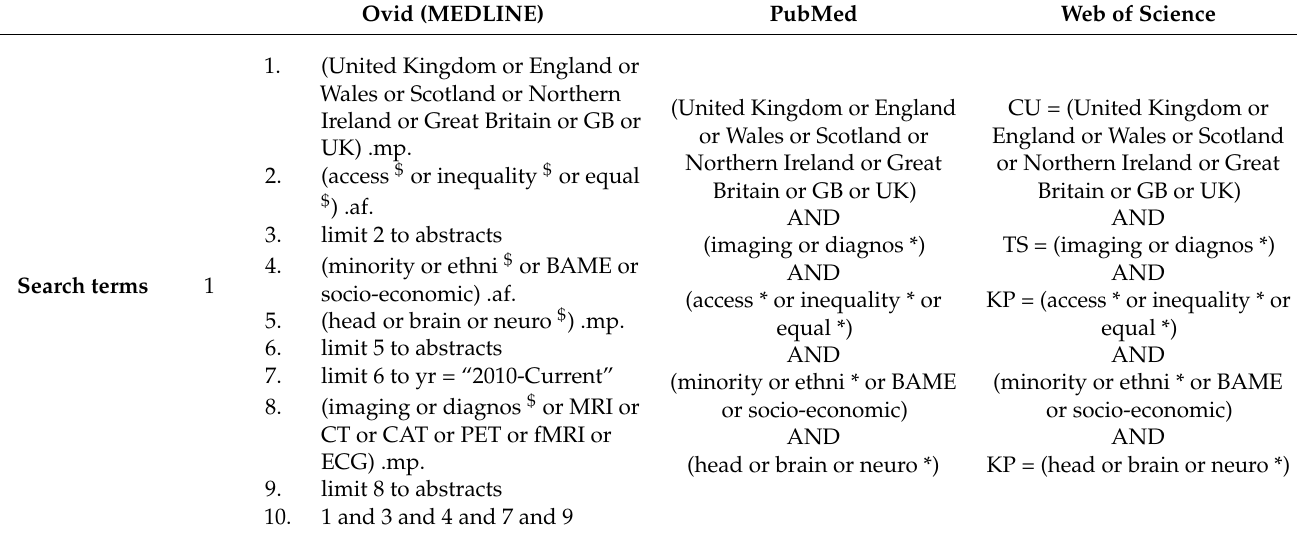
Table 4. Line-by-line search advance search